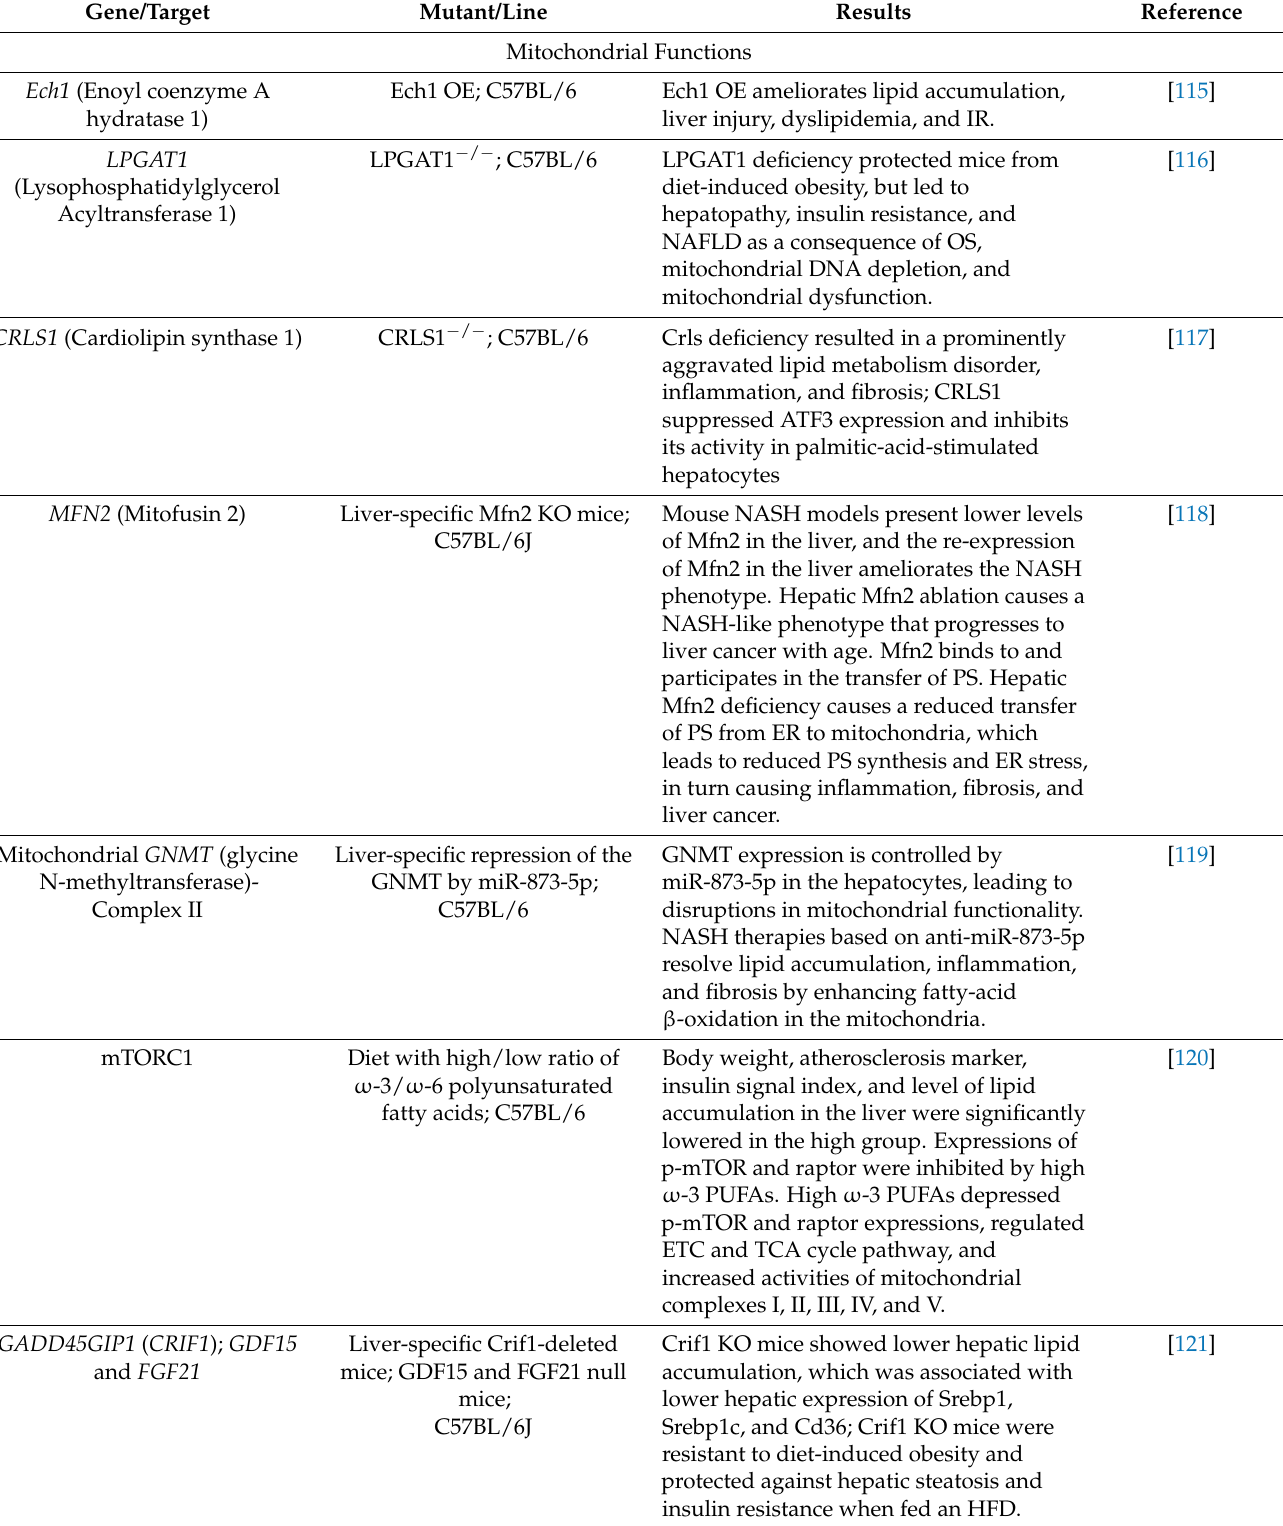
Table 1. Recent results obtained in mouse models and elucidating effects of different genes on molecular aspects of NAFLD pathogenesis and general lipid